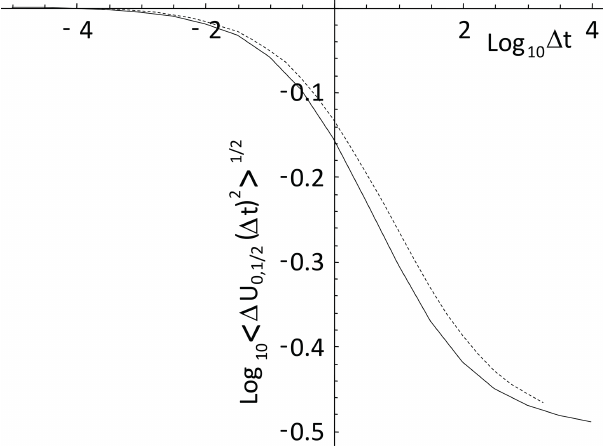
Figure B2. The logarithmic derivative of the rms Haar fluctuations of U 0 , 1 / 2 (solid) in Fig. B1 compared to a regression estimate over 2 orders of magnitude in scale (dashed; factors of 10 smaller and 10 larger than the indicated scale were used). This plot underlines the gradualness of the transition from slopes 0 to − 0 . 5 corresponding to apparent H = 0 to H = − 1 / 2 scaling. Over a range of 100 or so in scale there is approximate scaling but with exponents that depend on the range of scales covered by the data. If data were available only over a factor of 100 in scale, the rms Haar fluctuations could have any slope in the fGn range 0 to − 1 / 2, with only small